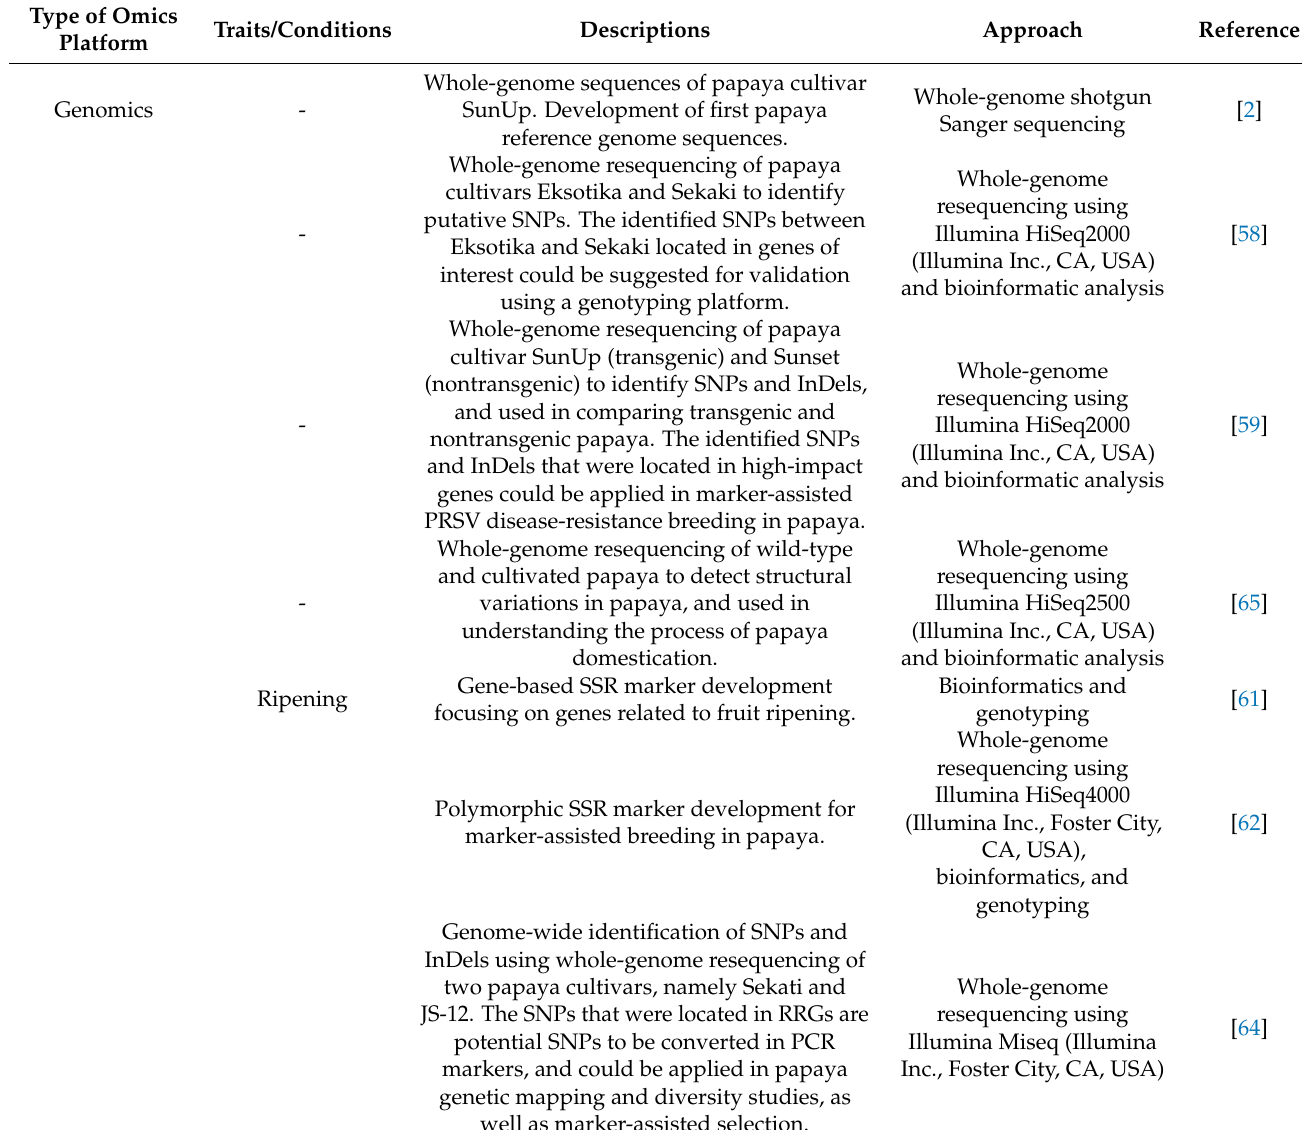
Table 1. A summary of the recent omics and bioinformatics approaches that are used in the improvement of papaya traits. Type of Omics Platform